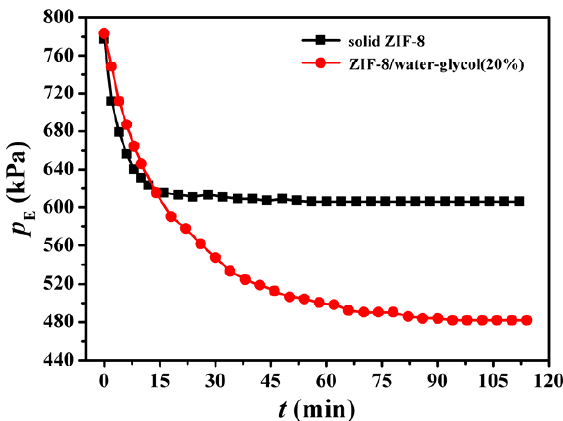
Figure 6. Kinetic curves for the ZIF ‐ 8 slurry containing different liquid media at 293.15 K and fixed initial pressure of 700 kPa. The solid content of ZIF ‐ 8 is 20 wt % for each slurry. The mass ratio between water and glycol in the ZIF ‐ 8/water ‐ glycol slurry is specified to 4:1.